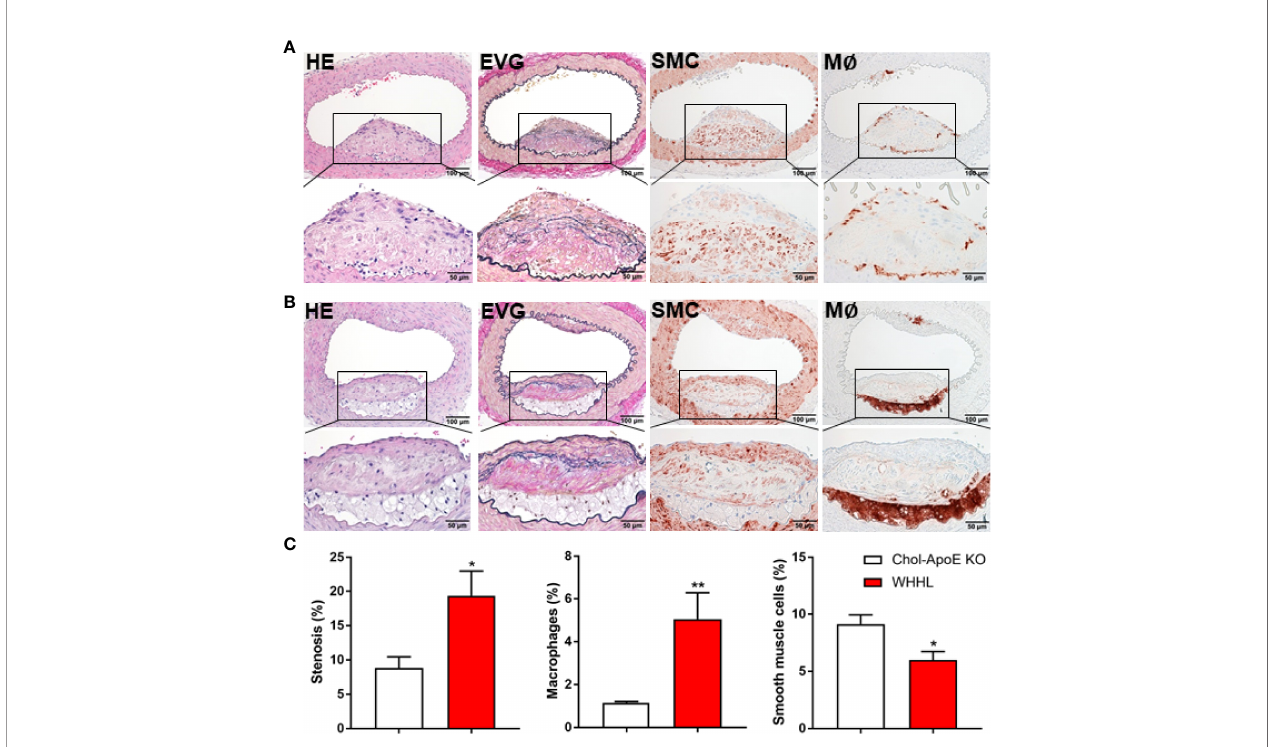
FIGURE 4 | Representative micrographs of intracranial atherosclerosis of WHHL rabbits fed on a normal regular diet. Among 15 rabbits, 13 rabbits showed various degree of the cerebral lesions. Most intimal lesions were characterized by fi brosis intermingled with smooth muscle cells in the center and few macrophages on the top [lesions of the basilar (A) ]. Two animals showed intimal lesions rich in macrophages at the bottom of the lesion (B) . Lumen stenosis rate, macrophages and smooth muscle cells in the arteries with the lesions of all sections (n=4 for apoE KO and n=32 for WHHL) were quanti fi ed, compared, and expressed as % (C) . *p<0.05, **p<0.01 vs. chol-apoE KO. Actual areas were shown in Supplemental Data ( S-Table 5